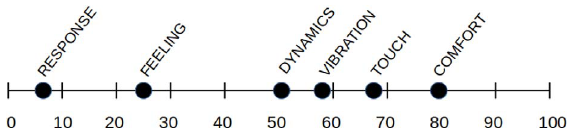
Figure 1. Percentage of utterances in relationship with the sense of touch for each